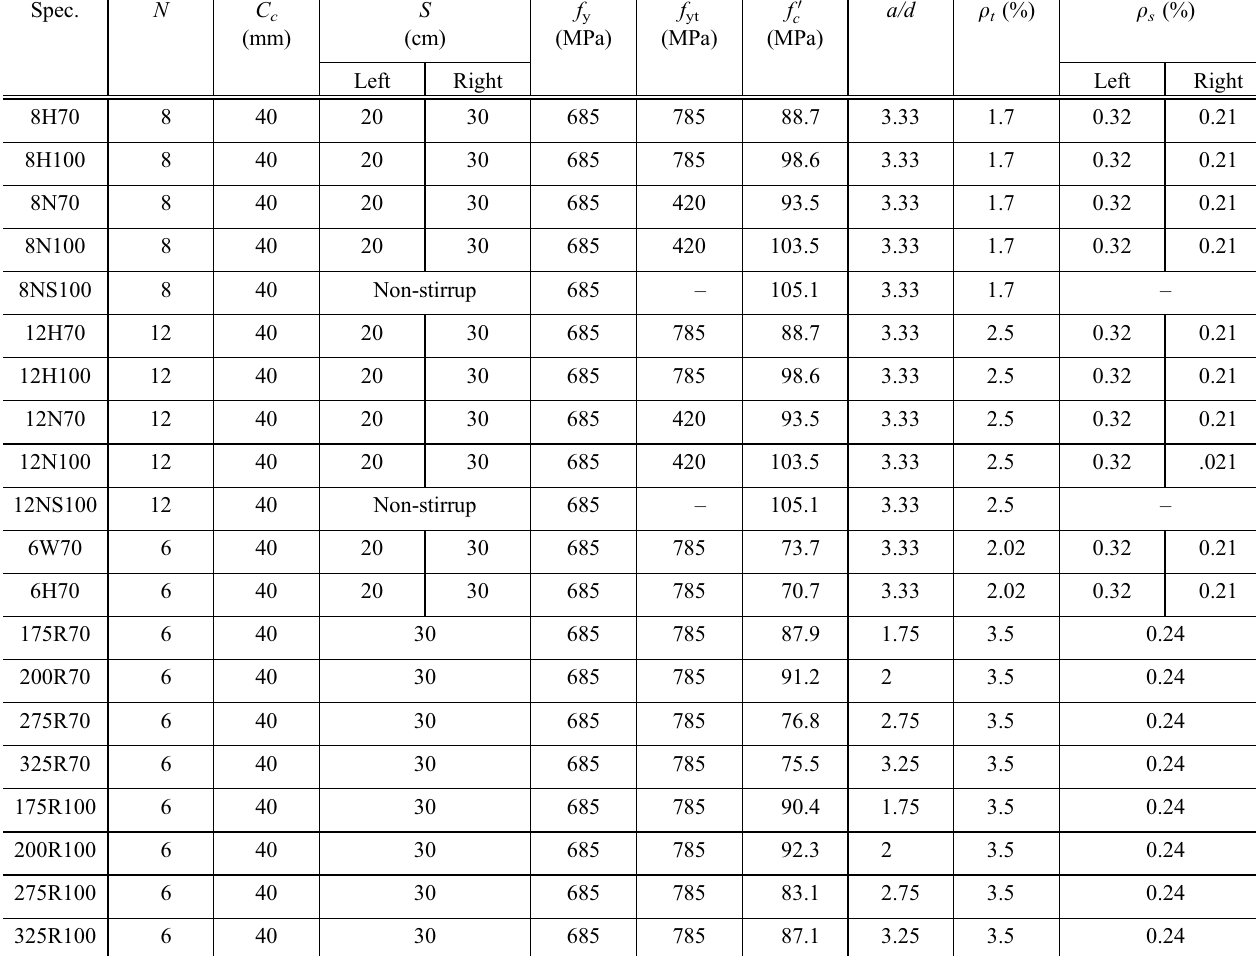
Table 1 HSRC Beam Specimens of the past researches (Chiu et al. 2014, 2016). Spec.